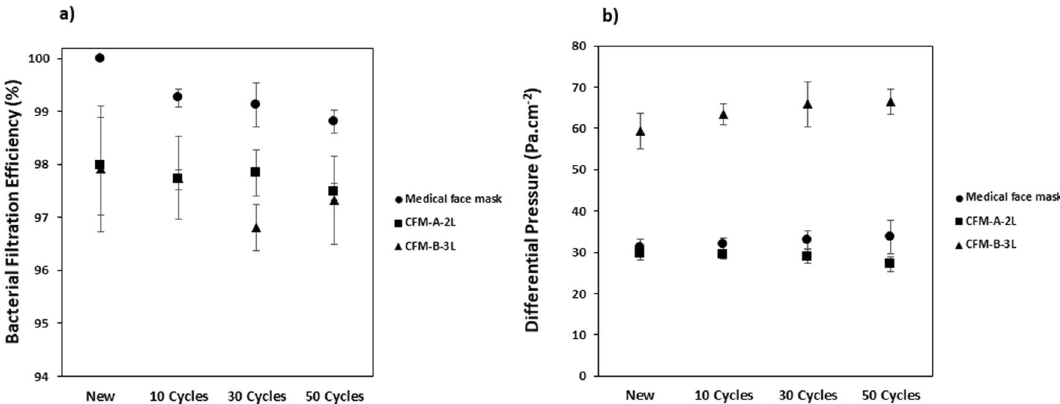
Figure 4. Influence of the wash cycles on the: ( a ) Bacterial Filtration Efficiency (%) and ( b ) Differential Pressure (Pa cm −2 ) on the medical face mask and community face masks. Average values (N = 5) ± standard-